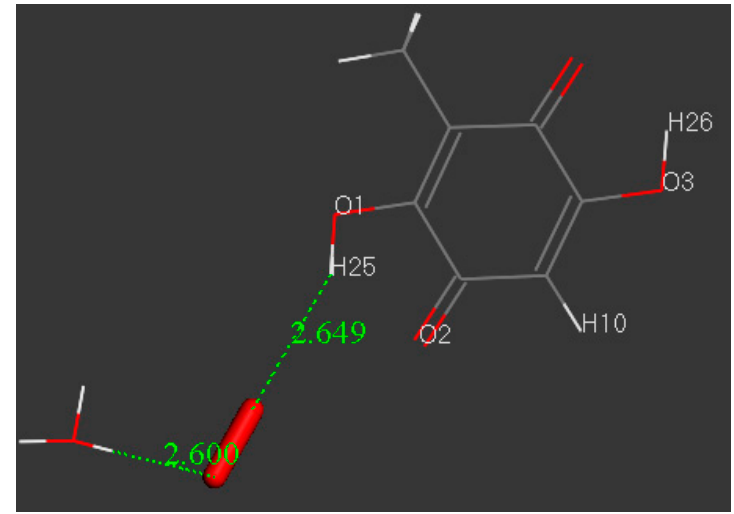
Figure 5. An attempt to force, on an embelin model, the σ scavenging of superoxide by adding a hydronium species, initially located at van der Waals separation of 2.60 Å.